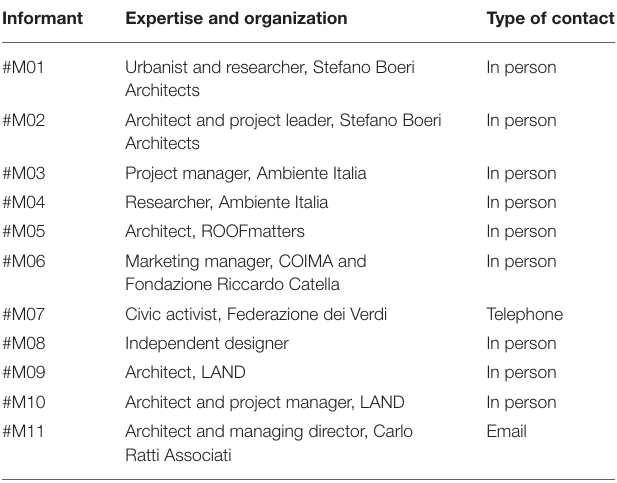
TABLE 1 | Key informants, experts (interview dates: between 04 and 05.